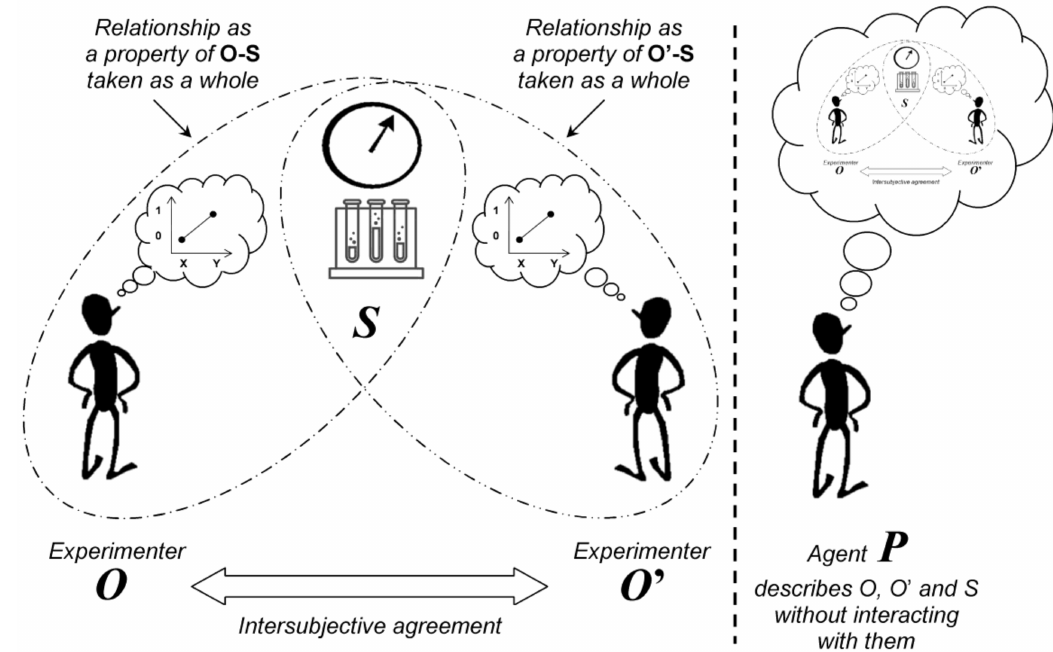
Figure 1. Experimental outcome as a property of system and observer taken as a whole when a relationship is assessed. After a measurement of the experimental system S by an experimenter O (or O ’) for a predefined relationship, the measured value is not a property of S alone, but is a property of O - S (or O ’- S ) taken as a whole. The experimenters agree on their observations (intersubjective agreement). The situation is described from the standpoint of an agent P who does not interact with O , O ’ and S . The agent P describes the experimental scene (including the experimenters and the observed system) in terms of probabilities of expected outcomes and interactions/measurements. Note that from the point of view of P , the order of the interactions of O , O ’ and S does not matter: e.g., O with S, then O ’ with S and, finally, O-S with O ’- S ; O with S , and then O ’ with O - S